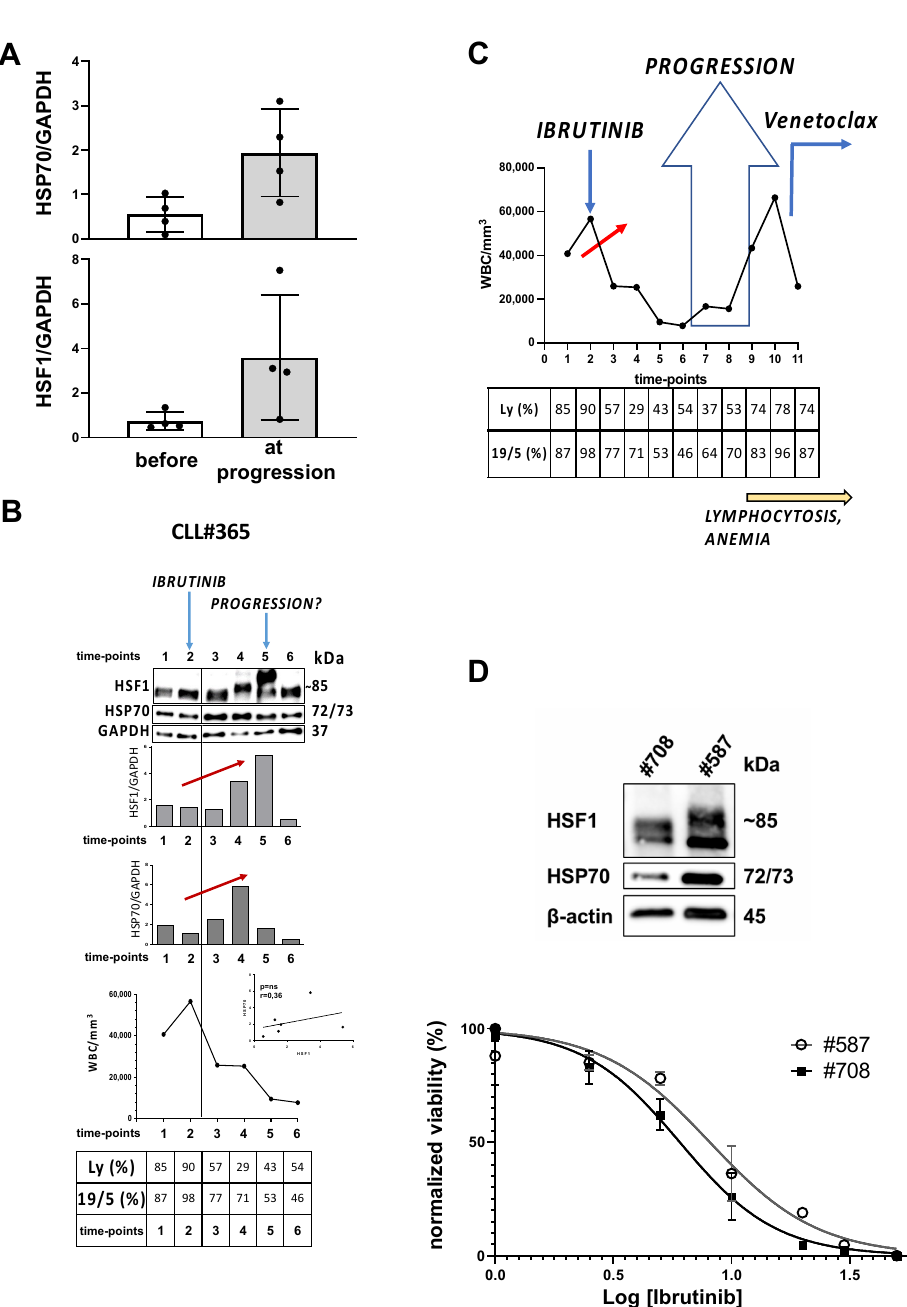
Figure 4. HSP70 and HSF1 expression levels predict clinical progression during ibrutinib treatment. ( A ). Histograms report the densitometric analysis of HSF1/GAPDH and HSP70/GAPDH ratios obtained after Western blotting analysis at the beginning of the treatment (before) and at a time-point identified as clinical progression (at progression). Analysis had been performed in four patients (#367, #447, #277, #202) who showed progression during ibrutinib assumption in vivo. ( B ). Data are related to patient #365 (time-points: 1 to 6). From top to bottom: analysis of HSF1, HSP70 and GAPDH by Western blotting; densitometric analysis of HSF1/GAPDH and HSP70/GAPDH ratios at the different time-points; patient’s white blood cell count; percentage of lymphocytes/total white blood cells; percentage of CD19 + /CD5 + lymphocytes/total number of lymphocytes. At the top of the sections, blue arrows indicate the start of treatment with ibrutinib and the start of the hypothetic progression. Inside the figure, red arrows indicate the increase in the expression of HSP70 and HSF1. Linear correlation graphs are related to HSP70 expression level vs. HSF1 expression levels at each time-point. WBC: white blood cells. ( C ). Data are related to patient #365 and proposed again in this figure with a wider time-range. From top to bottom: patient’s white blood cell count, percentage of lymphocytes/total white blood cells and percentage of CD19 + /CD5 + lymphocytes/total number of lymphocytes at different time-points. At the top of the sections, blue arrows indicate the start of treatment with ibrutinib and the start of another treatment (i.e., venetoclax, anti-Bcl2). The big blue arrow